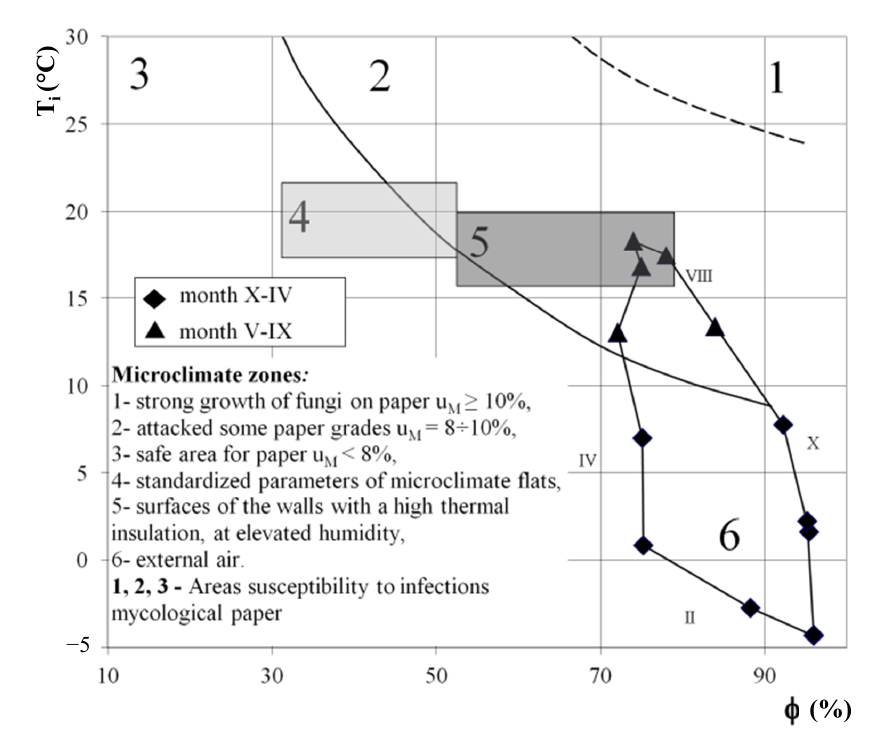
Figure 4. Microclimatic conditions of flats and requirements of molds [25].